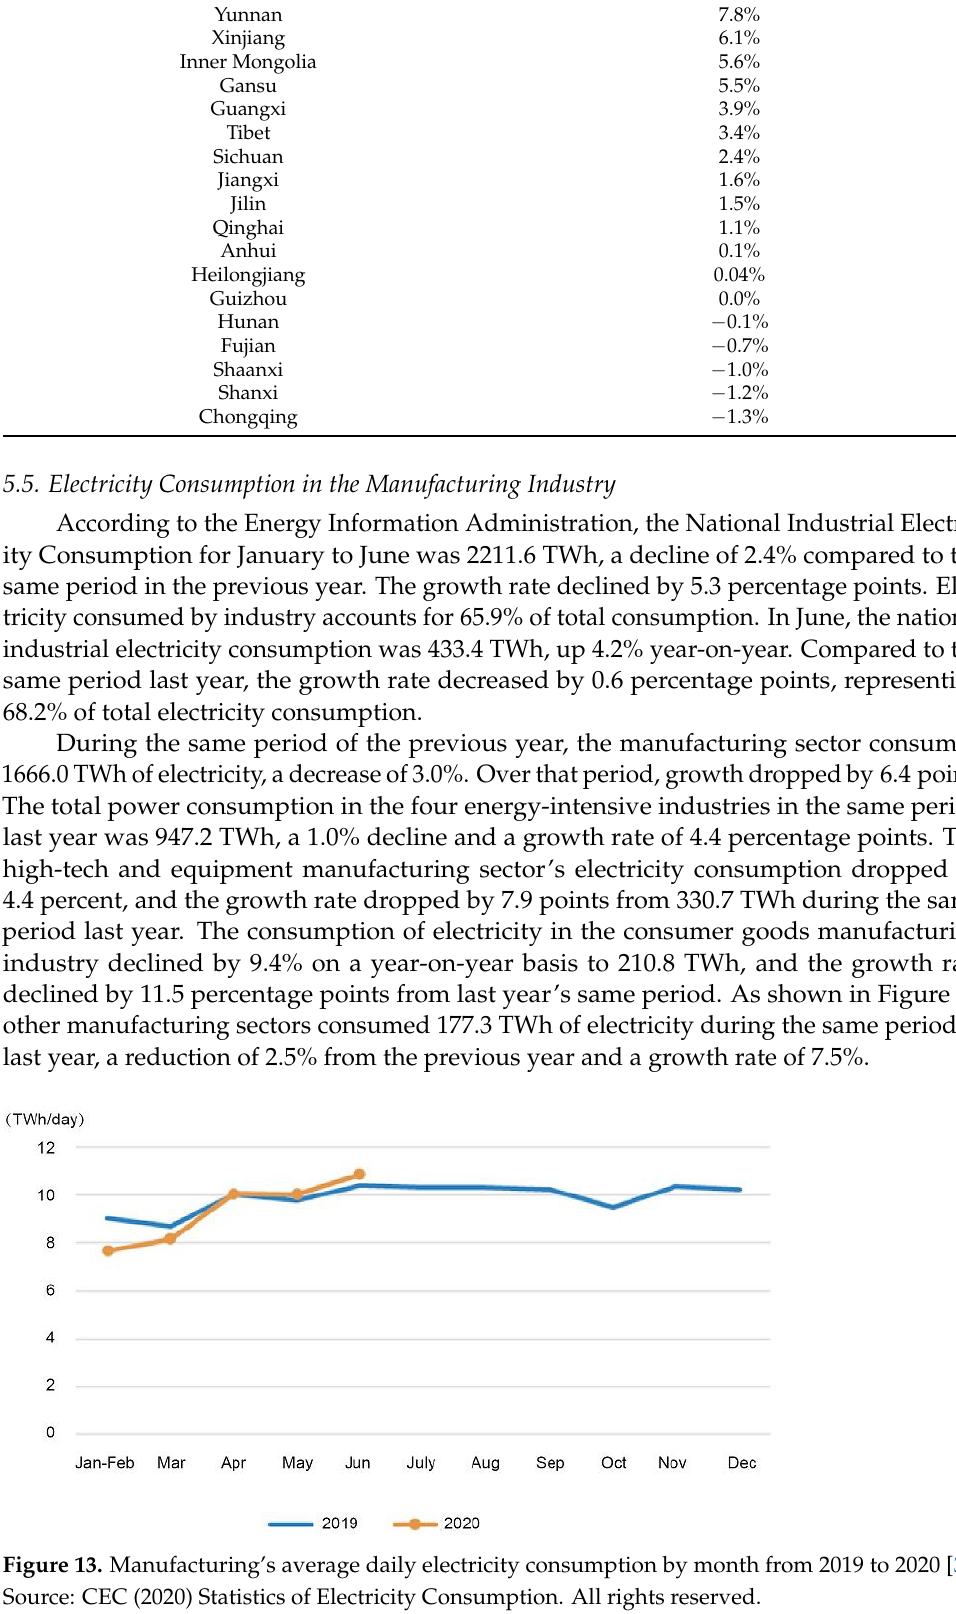
Table 5. Based on the YoY growth in electricity consumption from January to June 2020. Regions